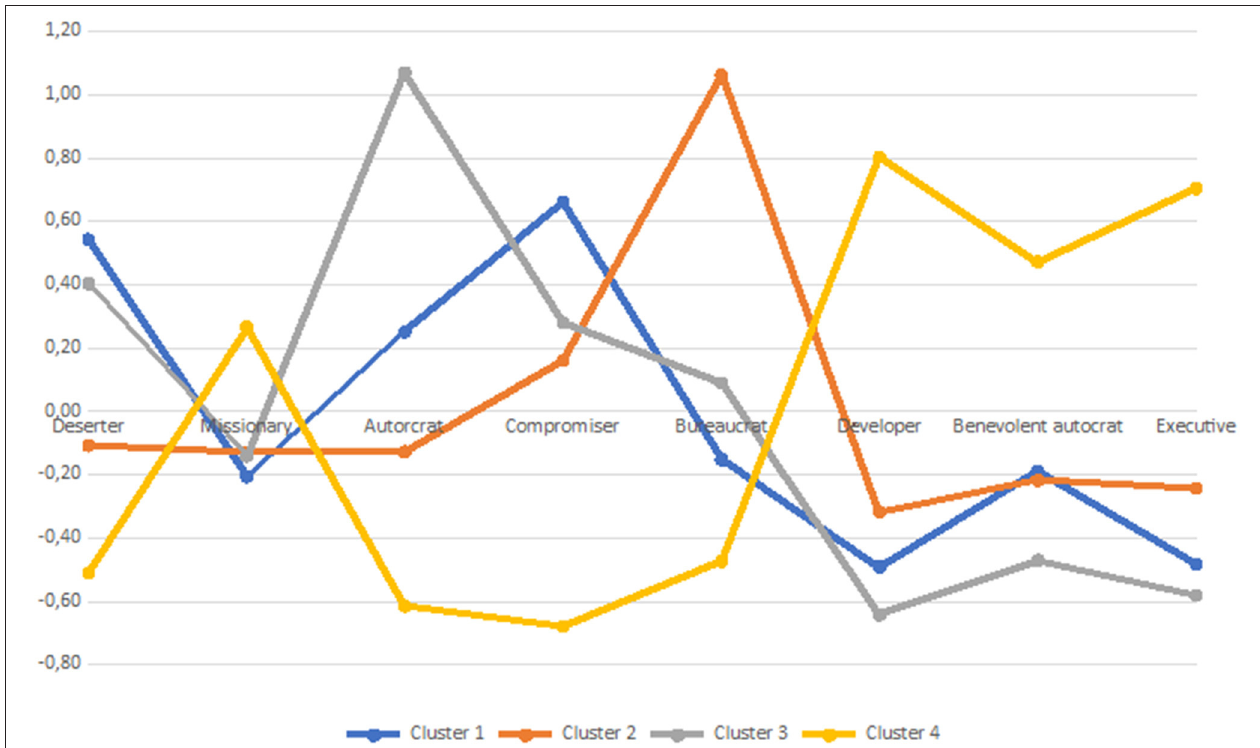
FIGURE 3 | Characteristics of clusters in terms of perceived management